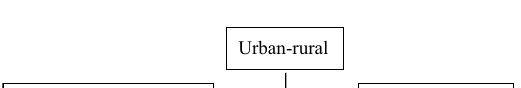
FIGURE 1 Moderation effect of urban-rural living area on the association between parents’ education level and university students’ mate